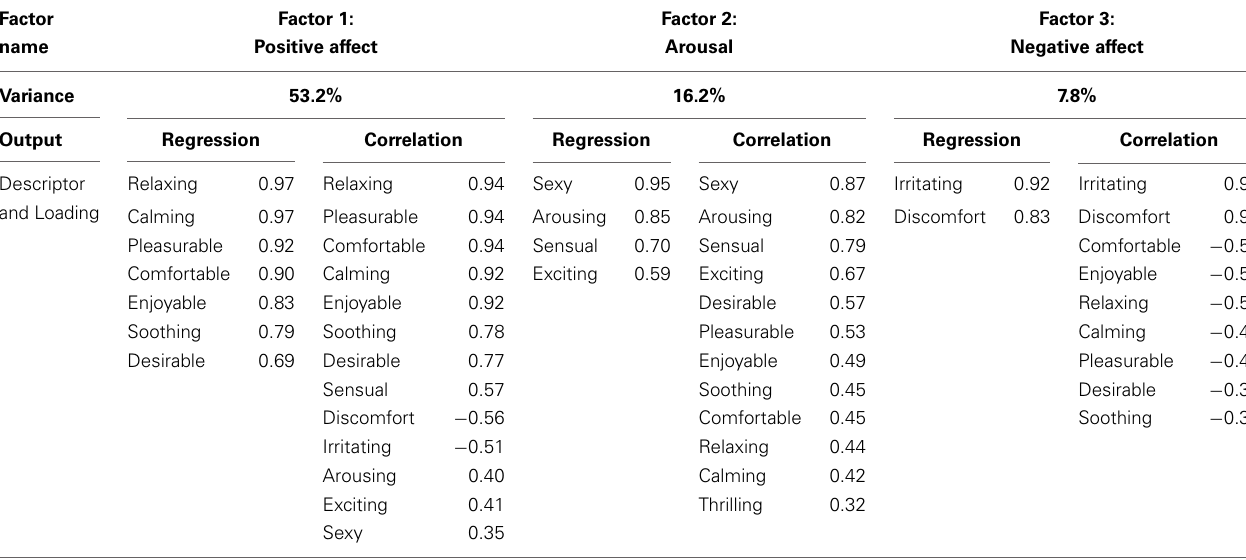
Table 4 | Emotional descriptors factor